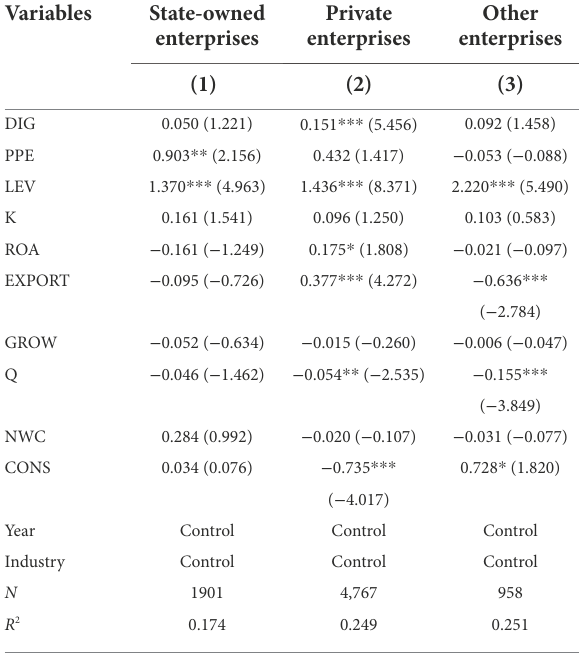
TABLE 8 Regression results for different enterprise